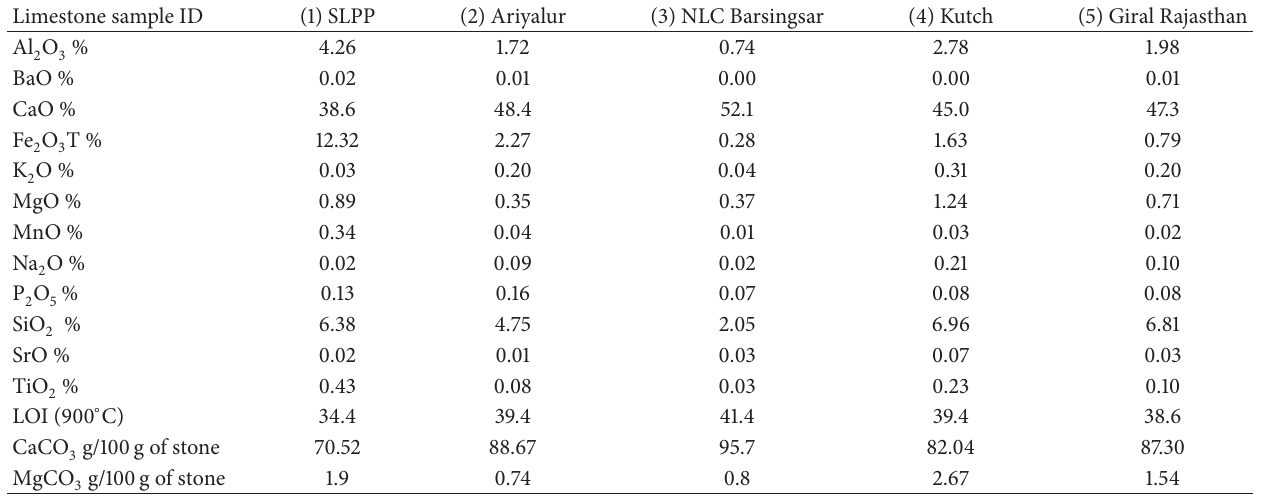
Table 3: Elemental analysis—calcium and magnesium carbonate contents of limestones.